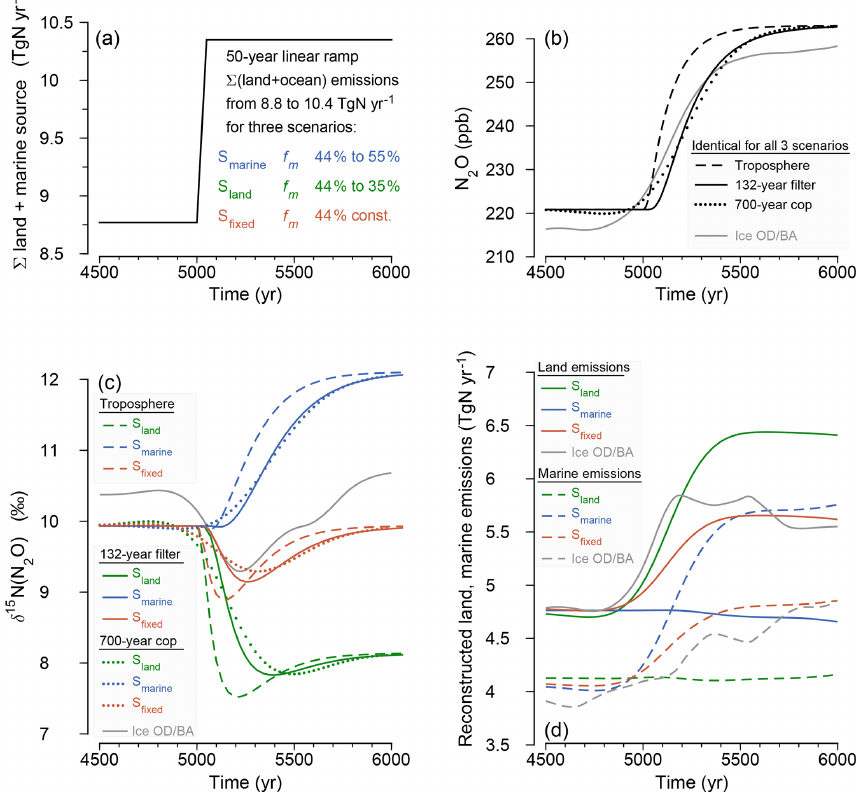
Figure 5. Deconvolution of artificial ice core data for a hypothetical 50-year emission ramp-up of (i) terrestrial emissions, (ii) marine emissions and (iii) terrestrial and marine emissions in a fixed ratio. (a) Assumed terrestrial and/or marine emission increases for scenarios (i) to (iii). The increase in total emissions is the same in all cases; however, the contributions of terrestrial and marine sources differ in the three scenarios. f m denotes the change in the fraction of marine to total emissions during these three runs. (b) Calculated N 2 O concentration before (dashed black line) and after low-pass filtering with a log-normal gas age distribution with a mean gas age of 132 years mimicking the bubble enclosure process (solid black line). The dotted black line represents the artificial ice core data after applying a spline approximation with a cutoff period of 700 years. (c) Calculated δ 15 N(N 2 O) before (dashed colored lines) and after low-pass filtering (solid colored lines) with the log-normal gas age distribution and after applying a spline approximation with cutoff period of 700 years (dotted colored lines), (d) deconvolution results using the data in (b) and (c) showing terrestrial (solid colored lines) and marine (dashed colored lines) emissions. Also plotted for comparison are the reconstructed emissions using the ice core data at the onset of the BA warming (grey lines in b – d ), where the ice core results are plotted on the model timescale assuming that the well-defined onset in the ice core CH 4 increase (vertical blue dashed line in Fig. 2) is synchronous with the onset of the N 2 O emission increase in the artificial